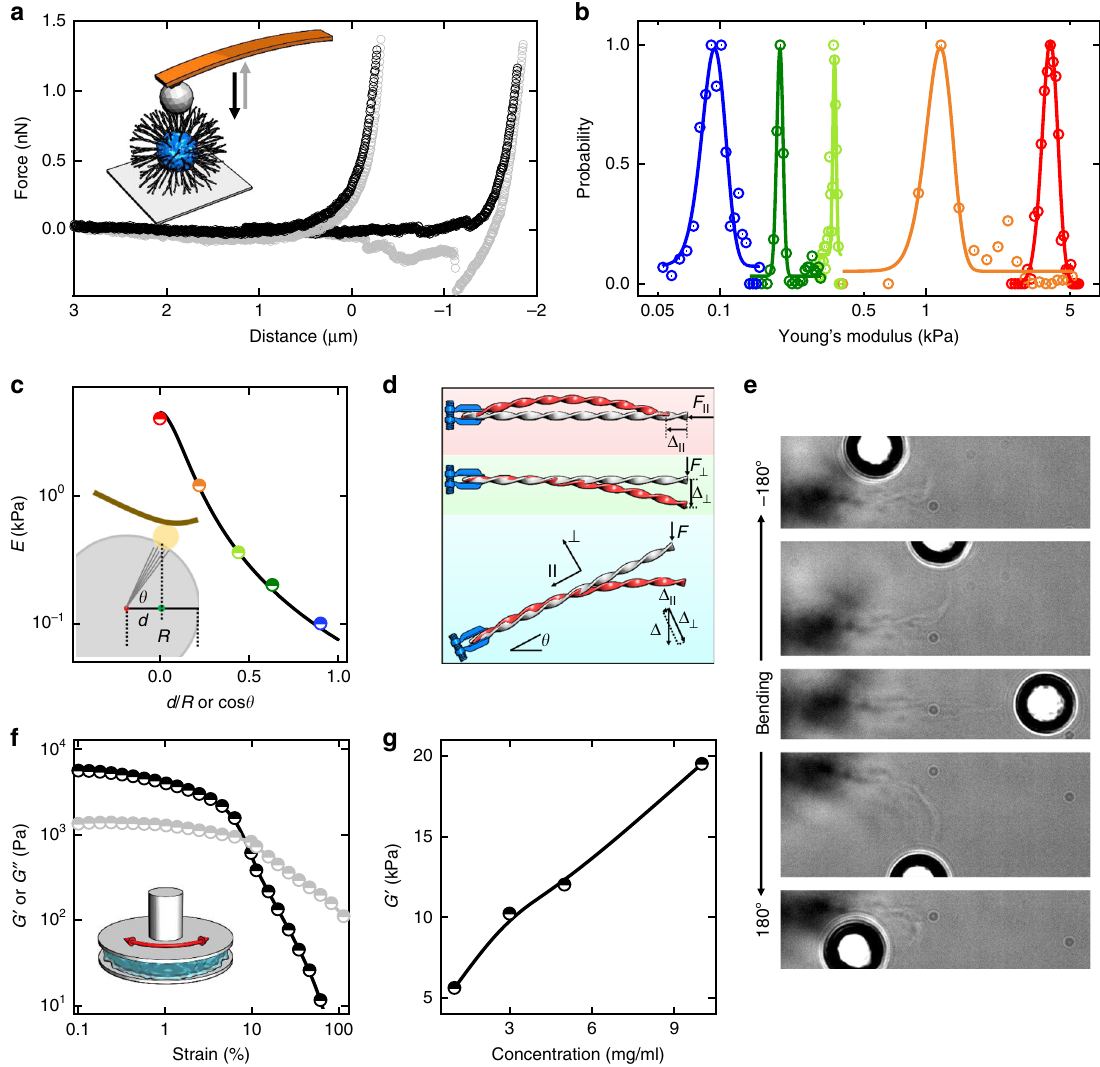
Fig. 5 Mechanical properties of the asters. a A 7- μ m silica sphere is attached to an AFM tip to probe the single asters; the indentation curves (black) can be fi tted by the Hertz model, giving E (Young ’ s modulus) ~6 kPa. Small hysteresis of the retraction curves (gray) suggests a fi nite energy dissipation. Sometimes we observe negative forces during retraction (the right curve), re fl ecting adhesion of the tip sphere to the aster. The two curves are horizontally shifted for clarity. b E drops signi fi cantly when the probed location is moved from the center to periphery (from blue to red). c Dependence of E as a function of d / R . Points are experimental data and black curve is the fi tting by the analytical function in the main text. The inset displays geometry of AFM measurements. d Schematic representation of ribbon deformation under force. e An aster sector is reversibly bent by an optical tweezer. The silica sphere is 10 μ m in diameter. f Shear moduli ( G ′ and G ″ , black and gray points, respectively) of the aster precipitate phase (1 mg/ml) measured by a rheometer. g Variation of G ′ as a function of surfactant